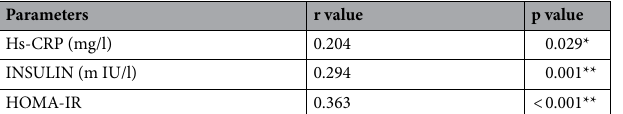
Table 5. Correlation of percentage expression of CD63 with hs-CRP, insulin and HOMA- IR score. Data represented as Spearman’s rho Correlation co-efficient ‘r’ with p-value. *p value significant at level of 0.05. **p value significant at level of